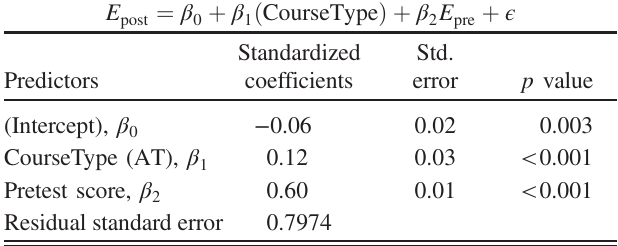
TABLE VII. Coefficients for ANCOVA for post-test scores while controlling for pretest scores for all students in the class. The table lists the standardized coefficients and the p values of the ANCOVA results for the CourseType category.